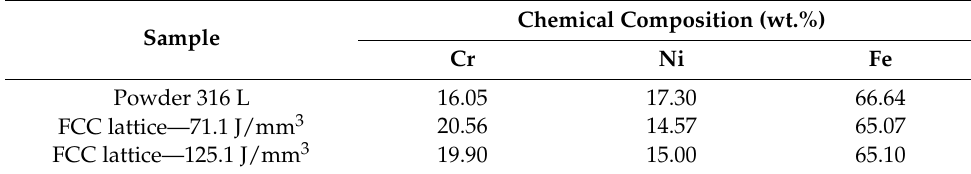
Table 3. Chemical composition results from EDX.